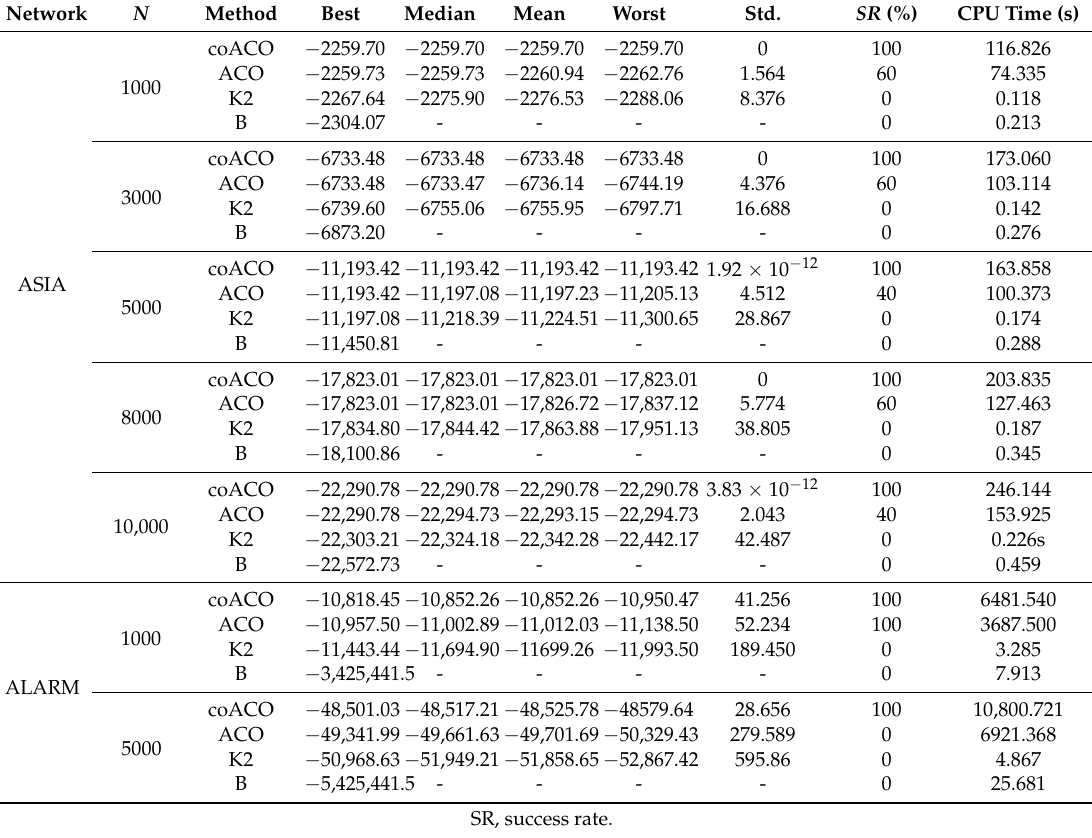
Table 2. Statistical results of the BIC score for various methods.